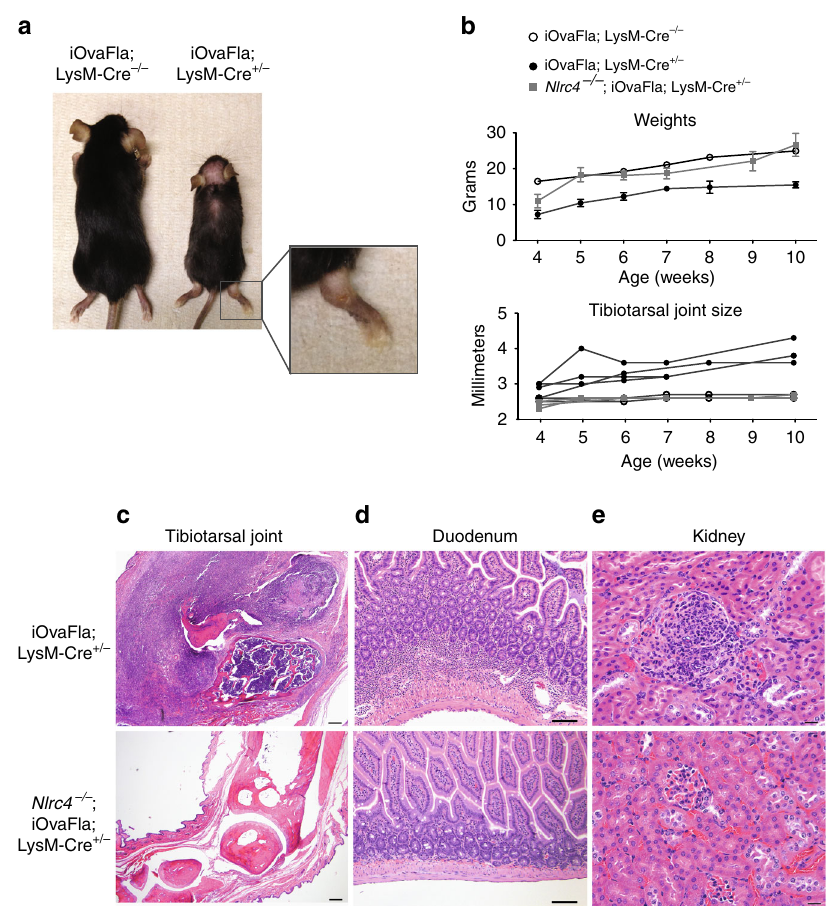
Fig. 2 Myeloid-speci fi c in fl ammasome activation generates systemic in fl ammation. Spontaneous in fl ammatory disease manifesting in the tibiotarsal joints a – c , the duodenum d , and kidney e of iOvaFla; LysM-Cre +/ − mice aged 10 – 14 weeks. a 14 week iOvaFla; LysM-Cre +/ − mice are runted and display joint disease compared to age and sex-matched iOvaFla; LysM-Cre – / − mice. b Weight and tibiotarsal joint swelling as the mice age ( n = 4 – 5 biological replicates per genotype). c – e Histology images showing c tibiotarsal joint, d duodenum, and e kidney damage in 10 week iOvaFla; LysM-Cre +/ − mice compared to Nlrc4 − / − ; iOvaFla; LysM-Cre +/ − mice (representative images from three biological replicates; tibiotarsal joint at magni fi cation ×40 and scale bar is 500 microns; duodenum at magni fi cation ×600 and scale bar is 20 microns; kidney at magni fi cation ×400 and scale bar is 20 microns). Data in c – e are representative of two independent experiments. Error bars are